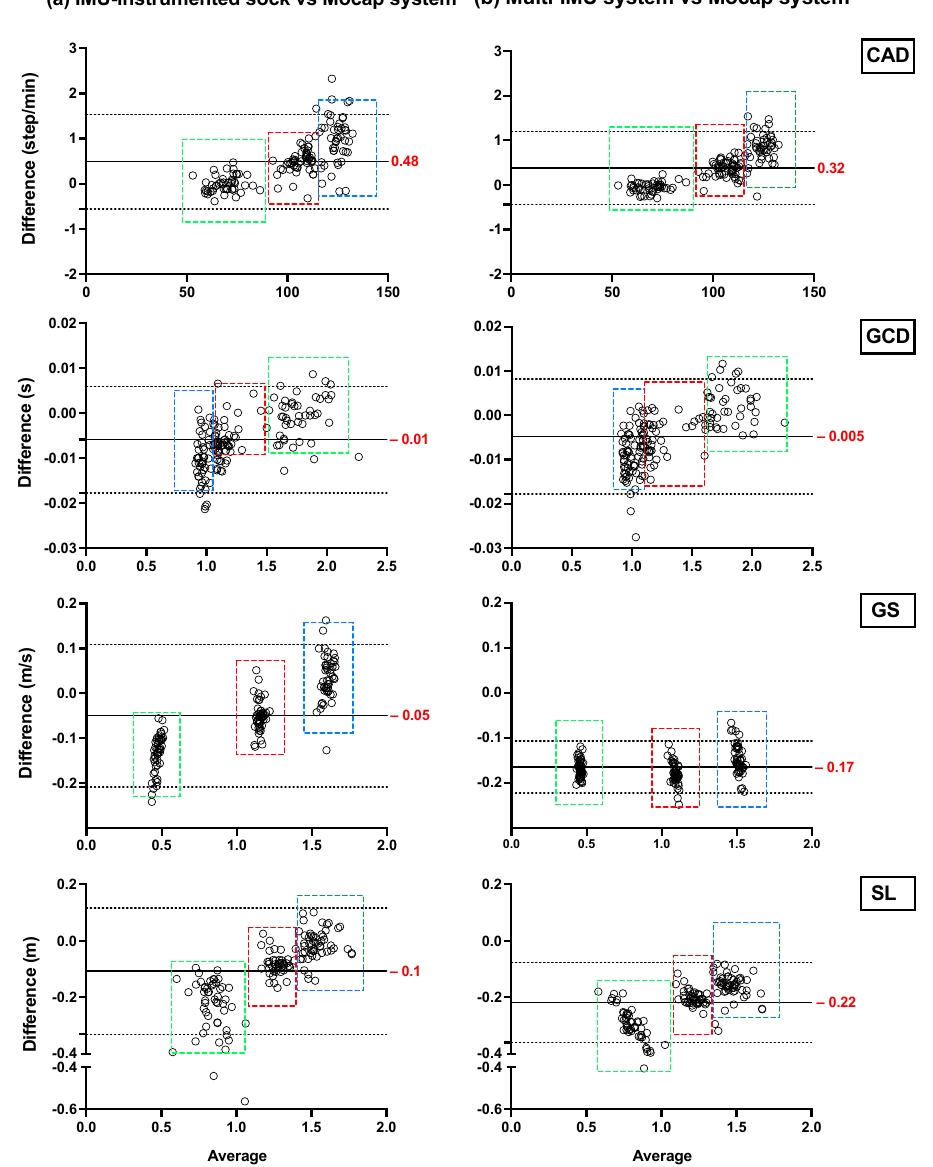
Figure 2. Concurrent validity. Bland–Altman plots of the differences between ( a ) the TEADRIP algorithm applied to the IMU-instrumented sock recordings and the Mocap system, and between ( b ) the Mobility Lab system and the Mocap system during two-minute treadmill walking at different speeds in HP (n = 25, 2 sessions). Cadence (CAD), gait cycle duration (GCD), gait speed (GS), stride length (SL), and Motion capture system (Mocap). The solid lines indicate the mean test-retest differences (bias) and the dashed lines indicate the upper and lower 95% limits of agreement (1.96 SD of the bias). Dashed green, red, and blue squares represent the observations for slow, normal, and fast speeds,